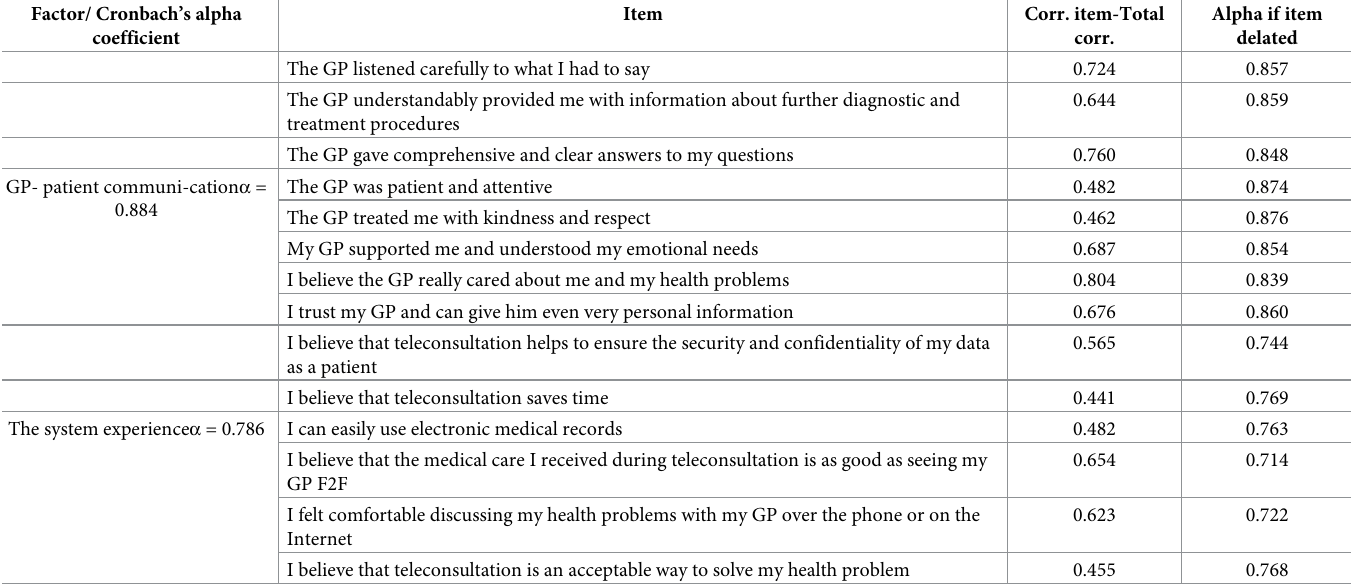
Table 4. Results of the reliability analysis of the measuring scales. Factor/ Cronbach’s alpha